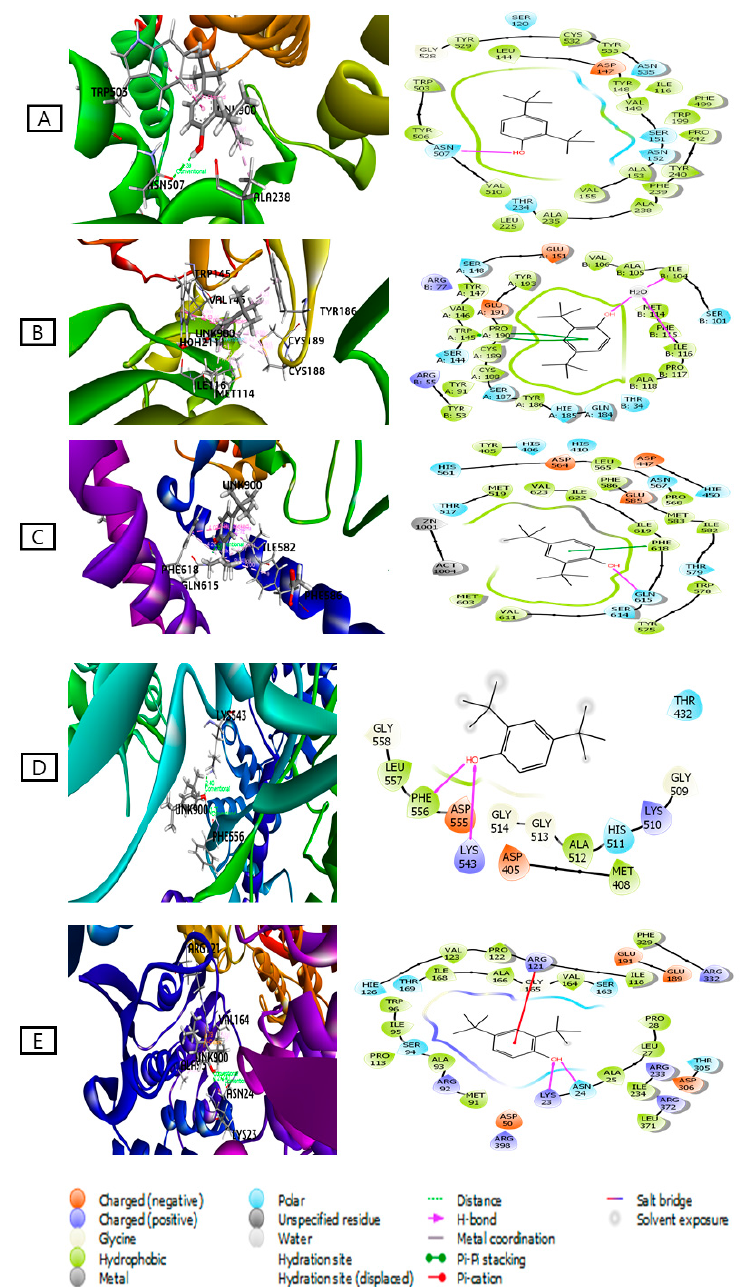
Figure 3. Best mode of 3D and 2D interaction of 2,4-di- tert -butylphenol with respective target proteins: ( A ) M3 muscarinic acetylcholine receptor (PDB ID: 4U14); ( B ) 5-HT3 receptor (PDB ID: 5AIN); ( C ) Gut inhibitory Phosphodiesterase receptor (PDB ID: 5LAQ); ( D ) DNA polymerase III subunit alpha (PDB ID: 4JOM); ( E ) UDP- N -acetylglucosamine-1-carboxyvinyltransferase (PDB ID: 4R7U). Variable colors reveal the presence of variant residue type: Orange-Acidic (Asp, Glu); Green-Hydrophobic (Ala, Val, Ile, Leu, Tyr, Phe, Trp, Met, Cys, Pro); Purple-Basic (Lys, Arg); Sky blue-polar (Ser, Thr, Gln, Asn, His, Hie); Light gray-other (Gly, Water) and Dark gray-metal atoms. Several interactions with the target receptor are drawn with lines between ligand atoms and protein residues: Solid pink: H-bonds to the protein backbones, Green: Pi-Pi stacking interactions, Red: Pi-cation interactions. Ligands solvent exposure is traced with gray spheres. The line exhibited around the ligand is noted as “Protein Pocket” and is marked with the color of adjacent protein residues. The disintegration of the lines displayed the onset pocket of